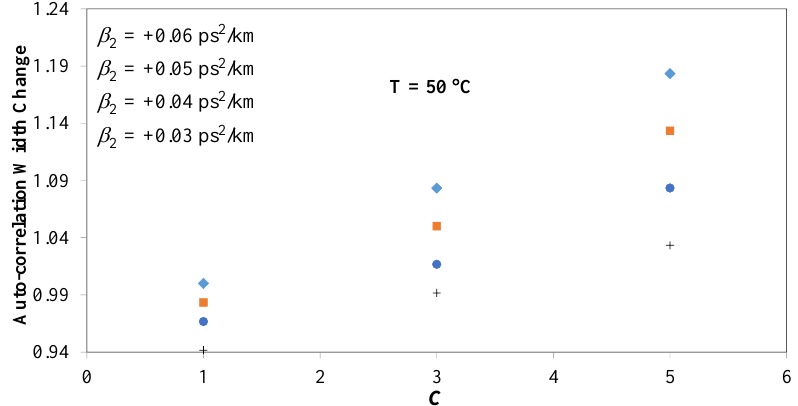
Figure 8. Compensation of the impact of β 2 on OCDMA auto-correlation width changes by using an SOA to control code carriers’ chirp at T = 50 ° C.